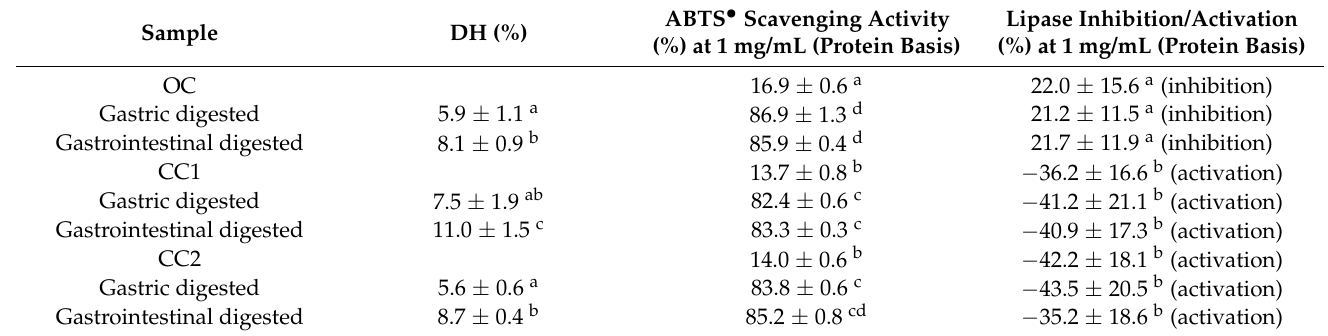
Table 3. Degree of hydrolysis (DH%), 2,2 (cid:48) -azino-bis(3-ethylbenzothiazoline-6-sulfonic acid) radical (ABTS • ) scavenging activity and lipase inhibitory/activatory activity of protein extracts from one organically (OC) and two conventionally (CC1 and CC2) cultivated hempseeds prior to and after in vitro simulated gastric and gastric followed by intestinal digestion.